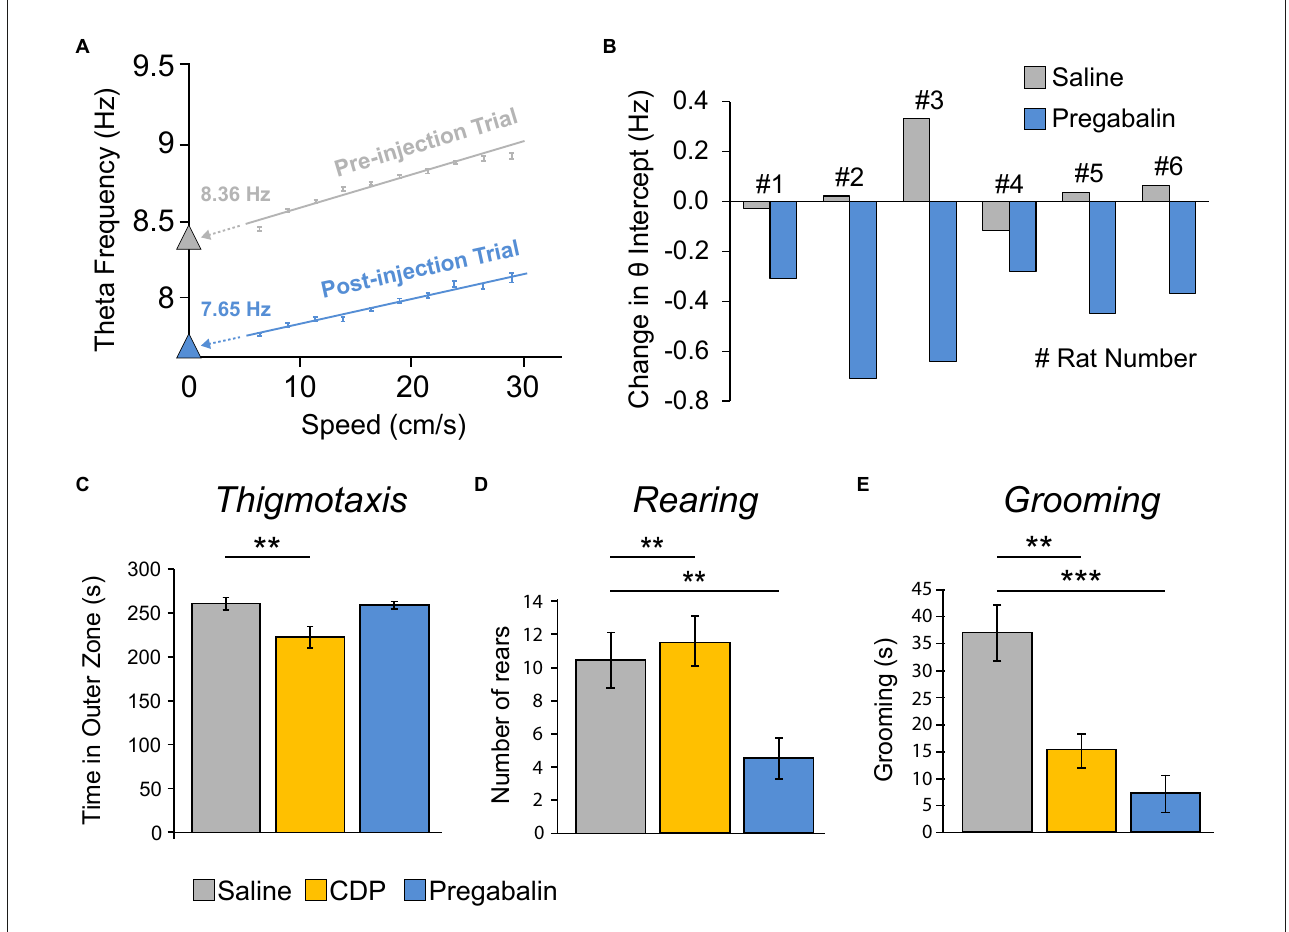
FIGURE7 The anxiolytic drug Pregabalin reduced the theta intercept component of theta frequency (but did not elicit classic signs of anxiolysis in a separate Open Field experiment). (A) Single example showing theta intercept reduction by systemic injection of pregabalin. Theta frequency to speed relationship over 5–30 cm/s running speeds for pre-injection trial (grey, trial 4) and trial after higher dose (35 mg/kg, i.p.) injection of pregabalin (blue, trial 5). Theta frequency to speed regression methods as per Figure 4 . The y-intercept values (theta intercept) are extrapolations of frequency-to-speed regression line extended to Y axis. (B) Summary data showing net theta intercept reduction following pregabalin injection, relative to saline injection, for all seven rats tested. Each bar is the difference value [Trial 4 preinjection − Trial 5 postinjection] for saline day (grey) or pregabalin day (blue) for one rat. Doses (i.p.):